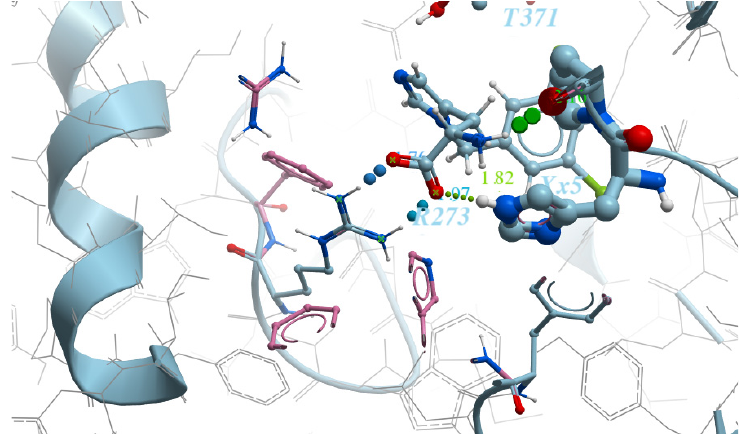
Figure 3. A salt bridge between ARG273 and the carboxyl group (first model of the ACE2 “grid”). Molecules 2021 , 26 , x FOR PEER REVIEW